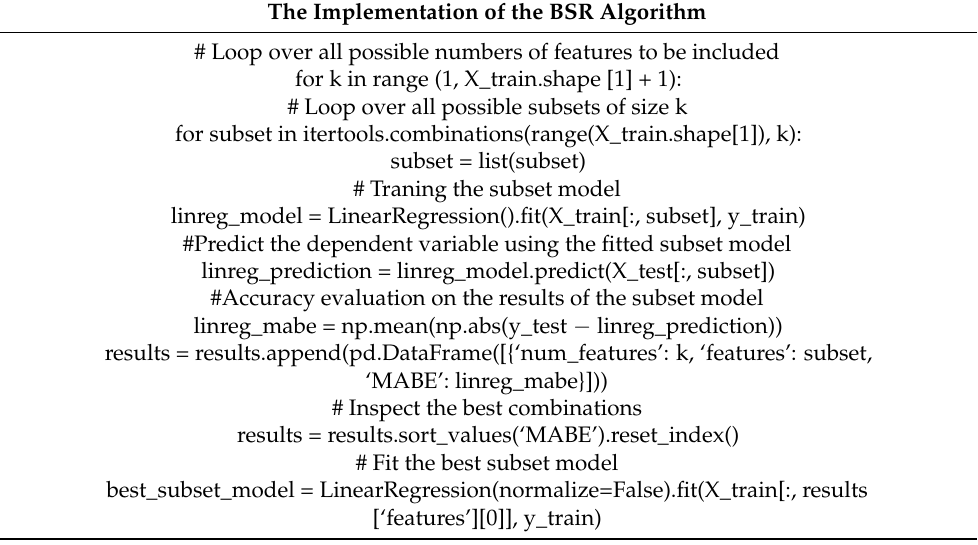
Table 2. The python code block of the BSR